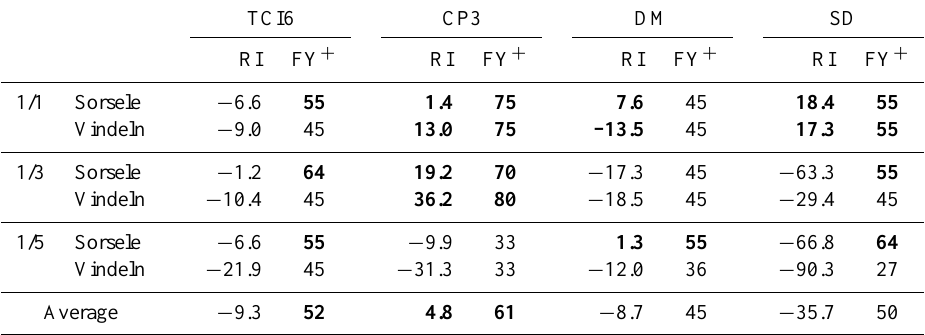
Table 2. Relative improvement RI (%) and frequency of years with a better performance FY + (%) of the new forecasting approaches TCI6, CP3, DM and SD, as compared with the climatological ensemble CE (boldface indicates better performance than CE). TCI6 CP3 DM SD RI FY + RI FY + RI FY + RI FY + 1/1 Sorsele − 6.6 55 Vindeln − 9.0 1/3 Sorsele Vindeln